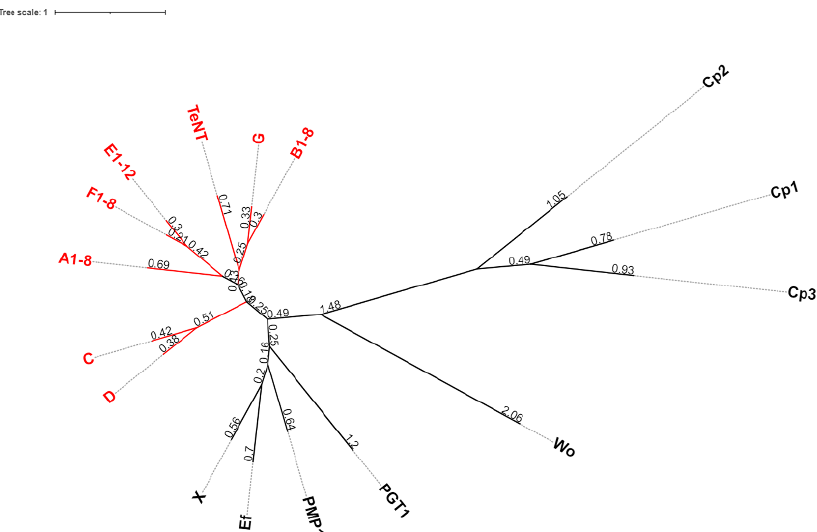
Figure 1. BoNT and homologs. The sequences for BoNT/A1, B1, C, D, E1, F1, G, X, Wo, Ef PMP1, PGT1, Wo, Cp1, Cp2, Cp3, and TeNT were aligned using Clustal Omega (default settings), and a phylogeny tree was created in IQTree [26] using ModelFinder [27] (model of substitution VT + F + G4). For PGT1, the LC and HC sequence were combined into one putative protein sequence. The tree was rendered in iTOL as an unrooted tree. Branch lengths are displayed, and the toxins known to be potent human and vertebrate neurotoxins are displayed in red. Funding: Funding for this work was from the National Institutes of Health, NIAID R01AI139306.